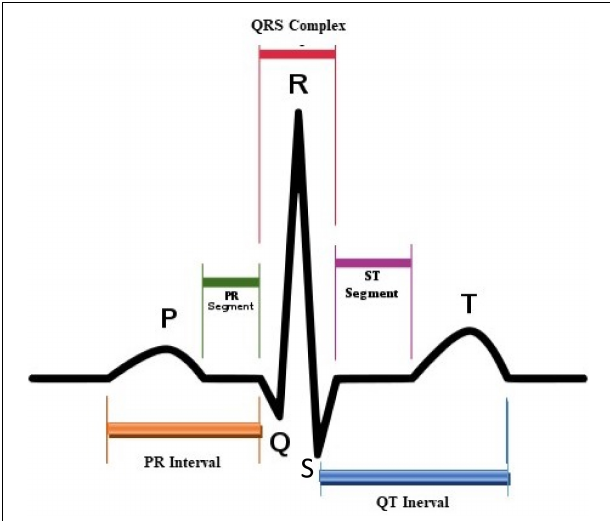
FIGURE 1 | ECG signal.